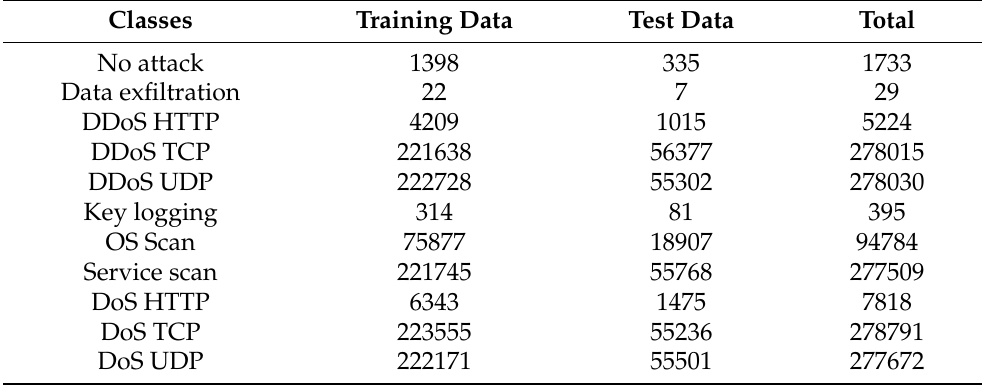
Table 6. Multi-class data